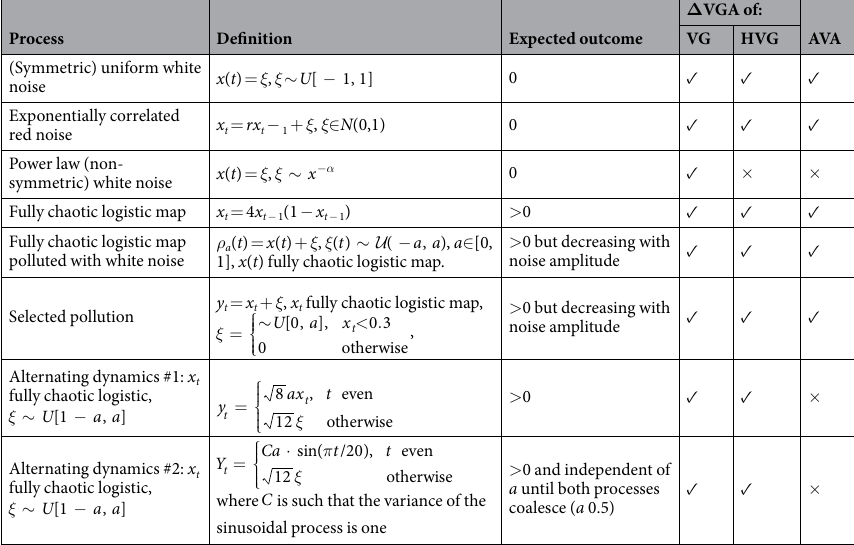
Table 1. Summary of results for synthetic processes. In every case we extract time series from the dynamical equations defined on the first column, and compare the results provided by the statistics Δ VGA (applied to VG and HVG) and AVA (computed from the logarithm of the Variance Ratio), see the text for